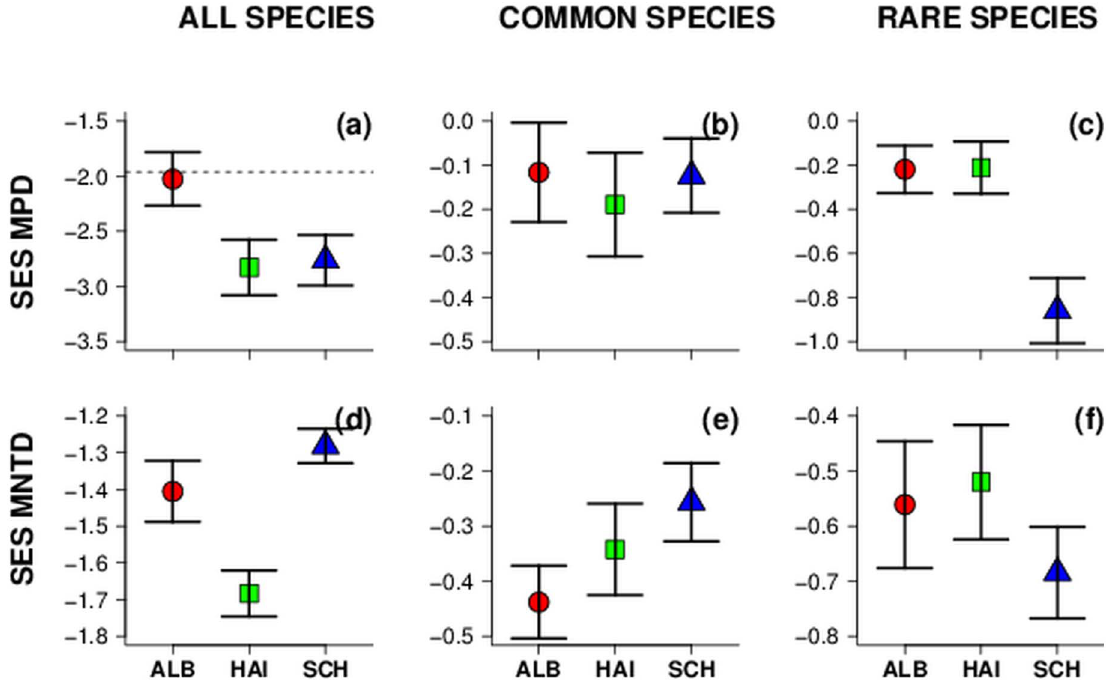
Figure 1. Mean ( 6 SE) values of MPD and MNTD effect sizes for total, common and rare species assemblages in three regions in Germany. (a)–(c) Mean MPD and (d)–(f) mean MNTD for all, common and rare species assemblages in the three regions. Region abbreviations: ALB=Schwa¨bischeAlb (red circle); HAI=Hainich-Du¨n (green square); SCH=Schorfheide-Chorin (blue triangle). Error bars indicate 6 SE. Points below the dashed line ( ,2 1.96) are significantly clustered. Note different scales of y-axes.